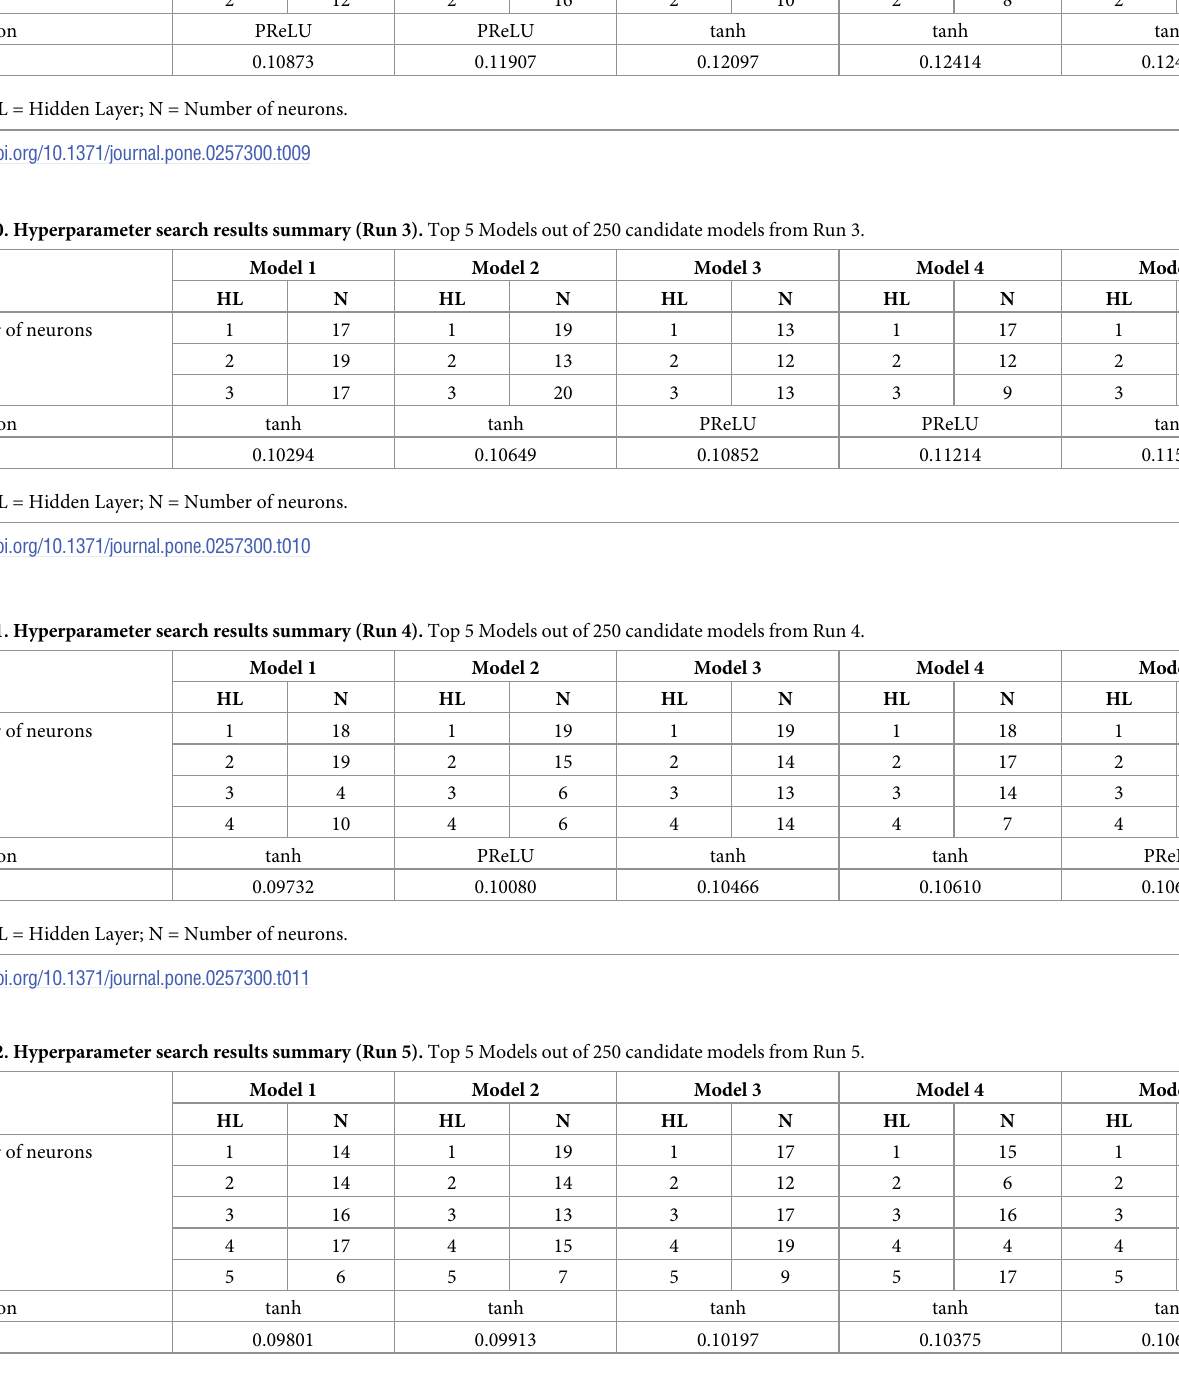
Number of neurons